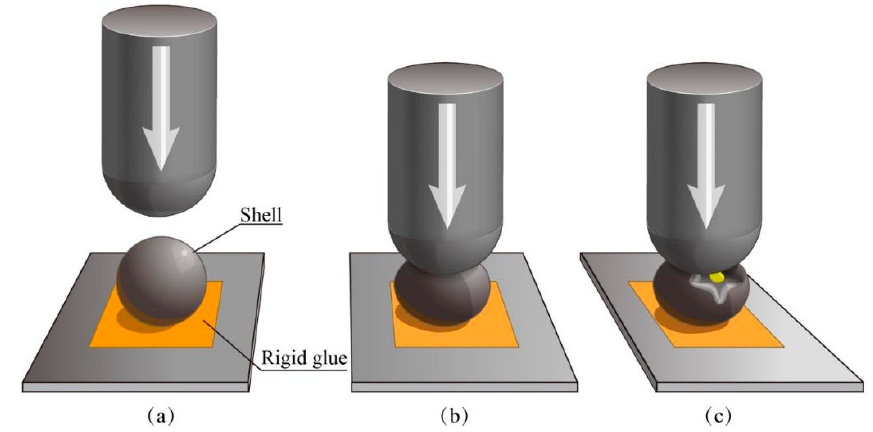
Figure 1. Illustration of nanoindentation method testing the mechanical property of single microcapsule, ( a ) a microcapsule rigid glued on a plate, ( b ) the elastic deformation on the microcapsule under pressure, and ( c ) a plastic deformation on the microcapsule under pressure. A Nano Indenter ® XP (MTS Nano Instruments, Keysight Technologies Inc., Palo Alto, CA , USA) cone tip (3 μ m radius) was out on a single microcapsule with a pressure as illustrated in Figure 1a,b. The force was set as 50 nN holding 10 s and displacement resolutions were 0.01 nm [26,41]. A load- displacement curve plotted out based on these output mechanical values with a yield stress. It has